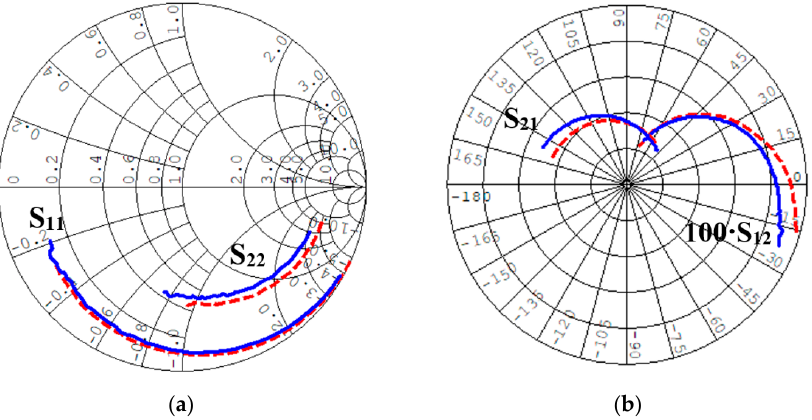
Figure 11. Scattering parameters measured by NRL with transmission lines (red dashed line) and UniME (blue solid line) for a HEMT with gate width of 2 × 50 μ m (3.5–26 GHz). ( a ) S 11 and S 22 , ( b ) S 21 and 100 · S 12 . V DS = 2 V and I DS = 20 mA.